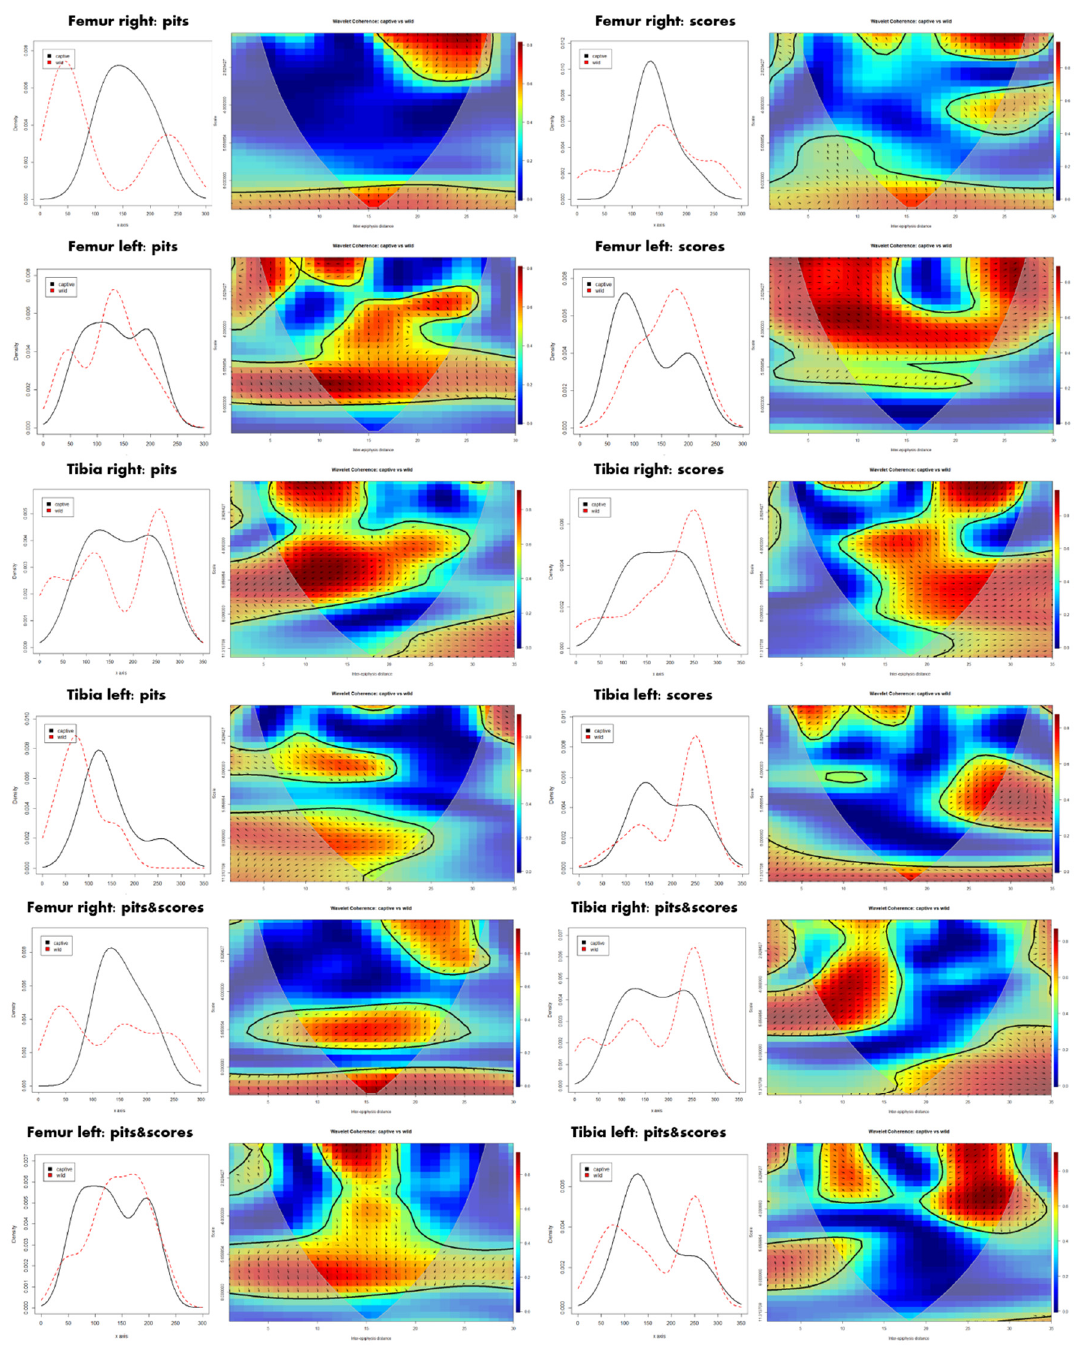
Figure 8. Pair histograms of tooth mark occurrence along the longitudinal bone axis and bivariate wavelet coherence plots showing the correlation of tooth modifications produced by wild and captive wolves on the proximal, midshaft, and distal portions of the analyzed femora and tibiae. The horizontal x-axis refers to the inter-epiphyseal distance from the distal to the proximal end of each bone, while the vertical y-axis refers to the scale. Correlation between both datasets is pseudo-color coded, with the correlation represented in red and no dependence indicated in blue. Arrows represent the lead/lag phase relations between the datasets. Arrows pointing to the right ( → ) indicate “time-series” to be in phase, i.e., they covary in the same direction. Arrows pointing to the left ( ← ) indicate “time series” to be in anti-phase, i.e., samples change in opposite directions. Arrows pointing to the bottom-right or upper-left indicate that the first variable (captive) is leading, while arrows pointing to the upper-right or bottom-left indicate that the second variable (wild) is leading.